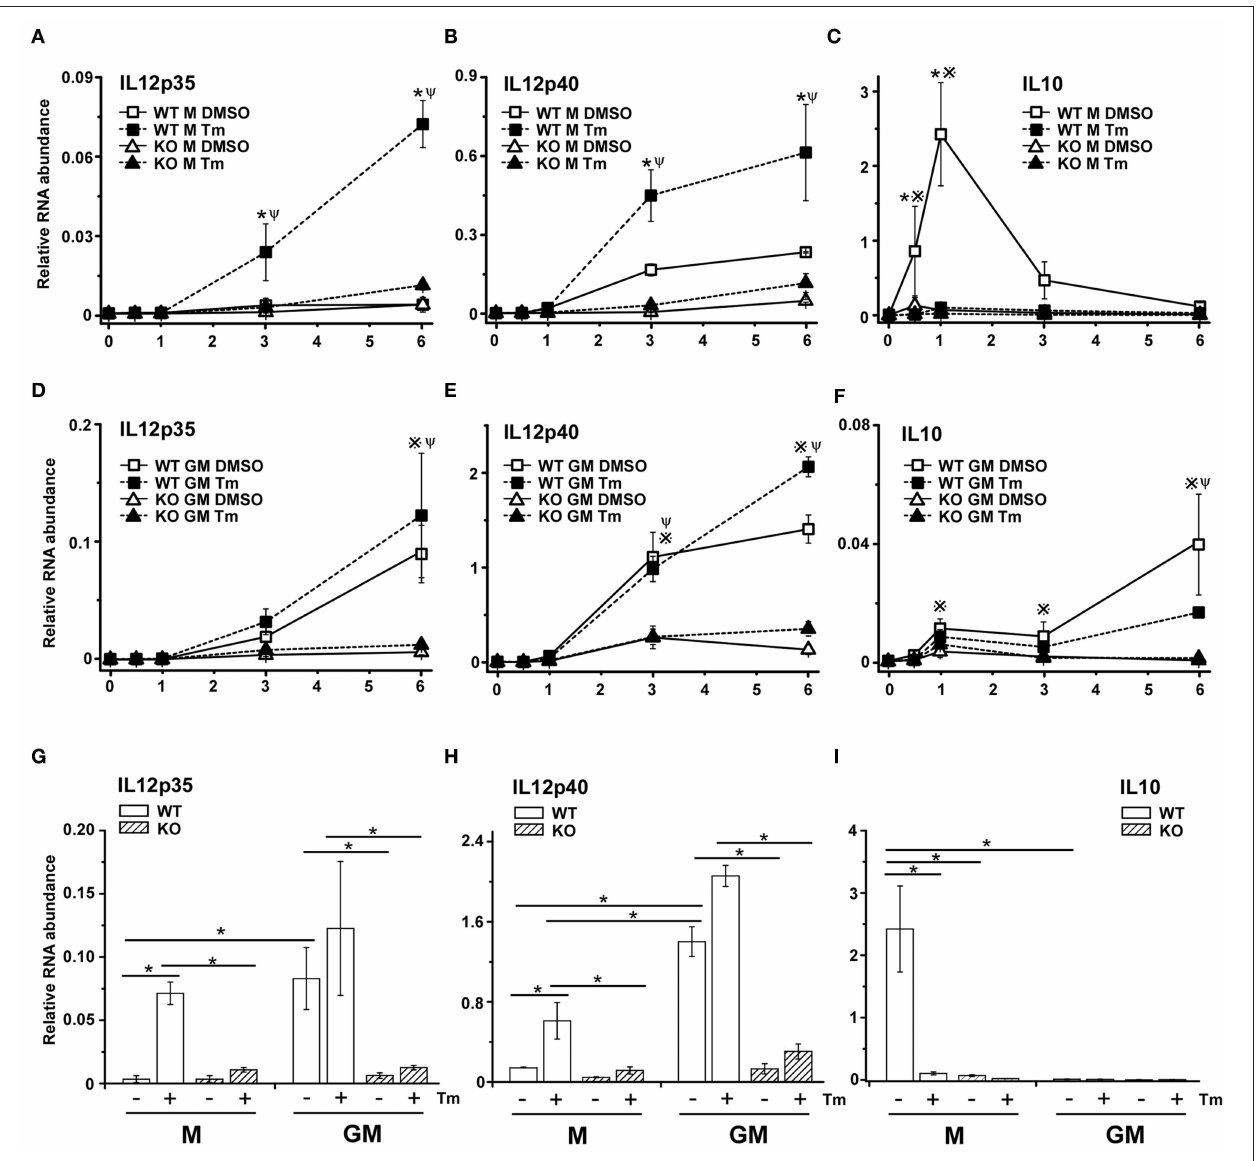
FIGURE 3 | The adaptor protein TRIF is necessary for stress-mediated change in TLR4-dependent cytokine mRNA expression. M-BMDM (A–C) or GM-BMDM (D–F) from wild type and TRIF-/- mice were treated with DMSO or Tm for 6h followed by LPS for the indicated times. Total RNA was prepared and used to determine IL12p35 (A,D) , IL12p40 (B,E) , or IL10 (C,F) mRNA levels by real time PCR. The mRNA levels of IL12p35 (G) and IL12p40 (H) after LPS stimulation for 6h and IL-10 after LPS stimulation for 1h (I) were compared between each group, respectively. Data are presented as the mean ± SD of triplicate experiments and the differences between indicated treatments were evaluated by two way-ANOVA and Turkey’s multiple comparisons test. In (A–F) , P < 0.05 is indicated by * for comparison of DMSO vs. stress in WT BMDMs, by # for comparison of DMSO vs. stress in TRIF-/- BMDMs, by ※ for comparison of WT DMSO vs. TRIF-/- DMSO and by 9 for comparison of WT stress vs. TRIF-/- stress. In (G–I) , P < 0.05 is indicated by * for comparison of the indicated